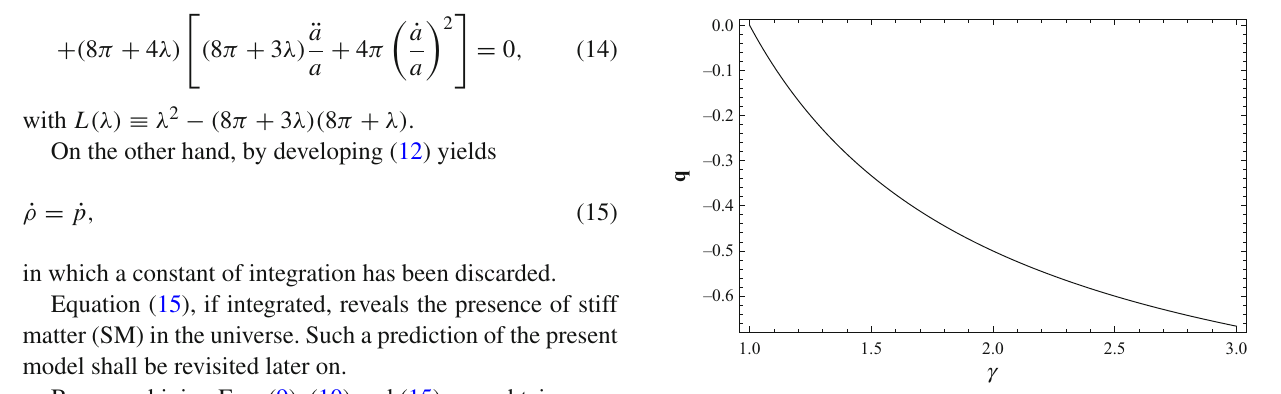
Fig. 1 Thedecelerationparameter q asafunctionofthefreeparameter γ